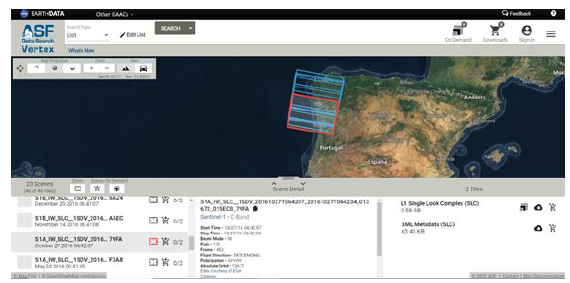
Figure 2 . Selection for downloading 22 radar images as slaves (in blue) and 1 master radar image (in red).